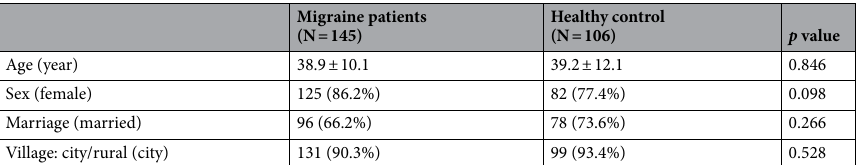
Table 1. Demographics of migraine patients and healthy control. p values were determined by independent t-tests for numerical variables and chi-square tests for categorical variables.